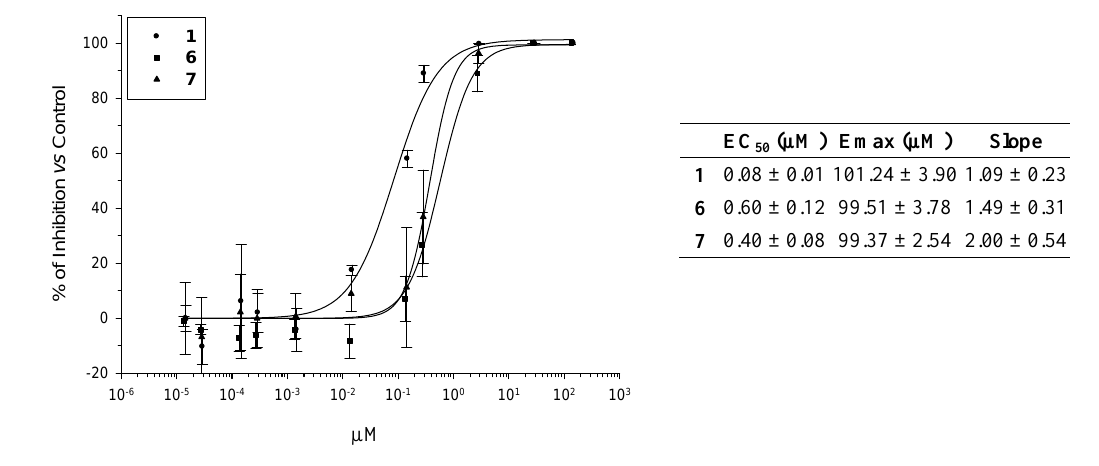
Figure 3. Therapeutic efficacy of pentamidine ( 1 ) and derivatives 6 and 7 against experimental Pneumocystis carinii pneumonia in nude rats (the numbers at the top of each bar graph indicate the % of inhibition versus control